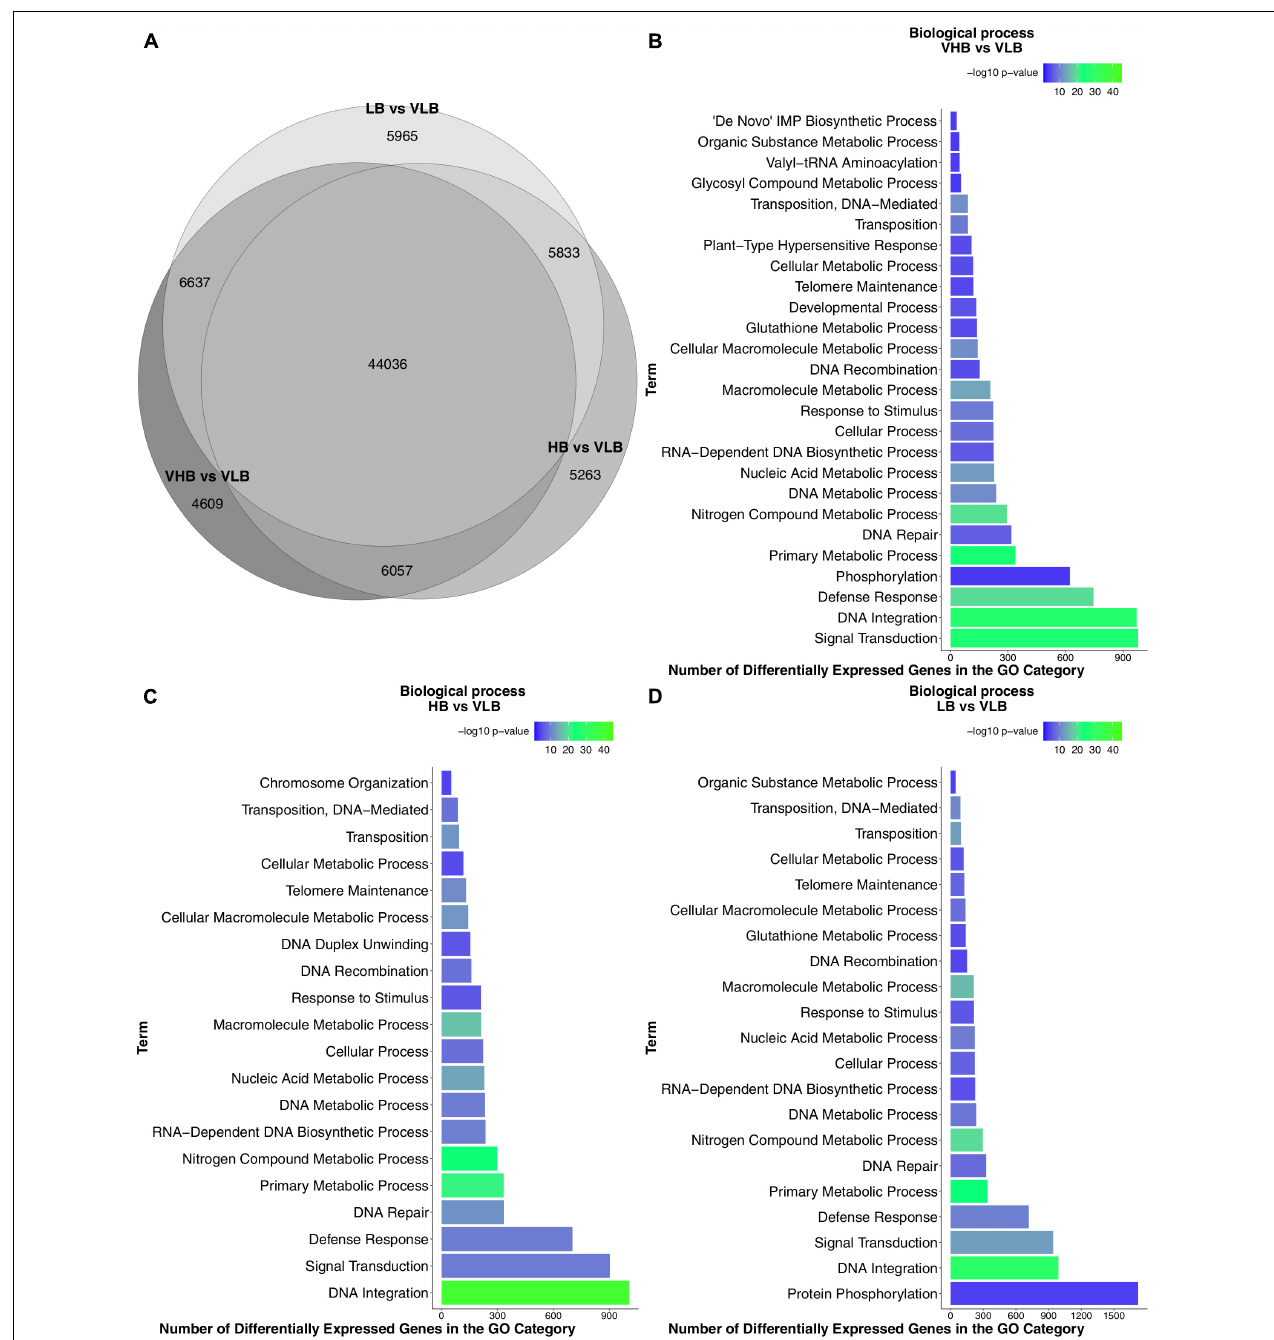
FIGURE 1 | Differential gene expression and functional enrichment results: (A) Venn diagram of differentially expressed genes (DEGs) found in tests for main effects. Enriched Gene Ontology (GO) terms of the biological process category: (B) VHB vs. VLB contrast; (C) HB vs. VLB contrast; and (D) LB vs. VLB contrast. VHB: very high ◦ Brix, HB: high ◦ Brix; LB: low ◦ Brix; and VLB: very low ◦ Brix.